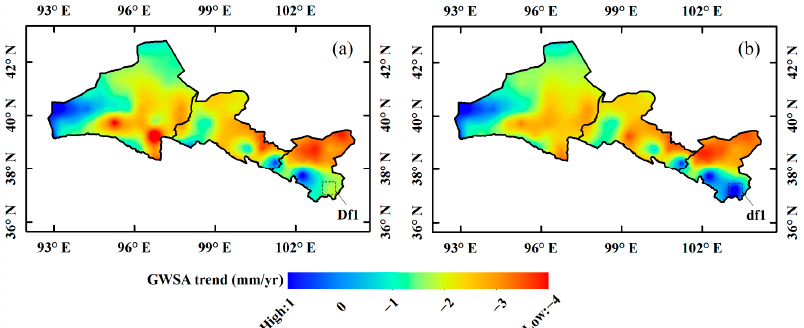
Figure 9. Comparison of the spatial-trend distribution in the Hexi corridor between the average results of original results (GRACE − GLDAS, GRACE − ERA5, and GRACE − WGHM) and GWFM- based GWSA. ( a ) GWFM; ( b ) average.